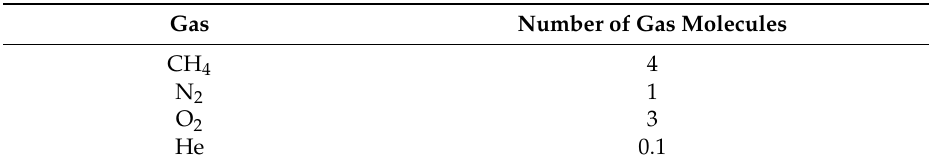
Table 3. The number of gas molecules in the simulation cell at T = 300 K, calculated on the basis of the excess chemical potentials obtained in molecular dynamics